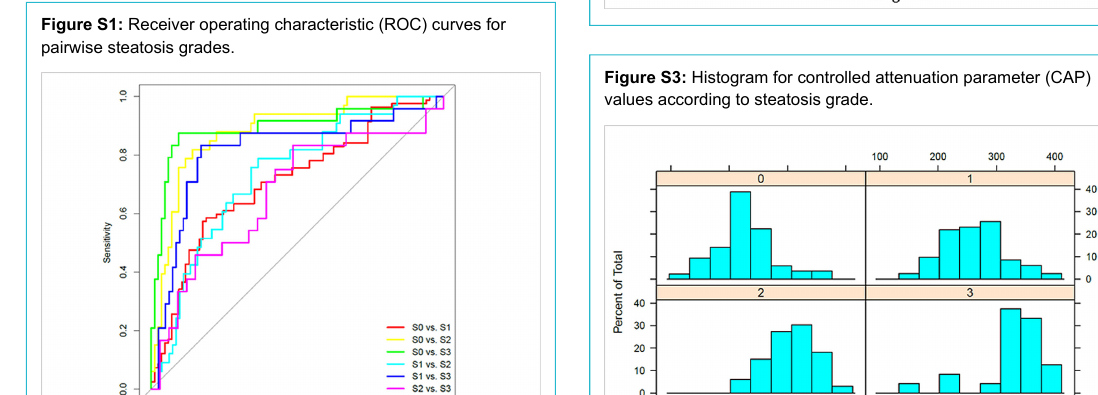
Figure S1: Receiver operating characteristic (ROC) curves for pairwise steatosis grades.